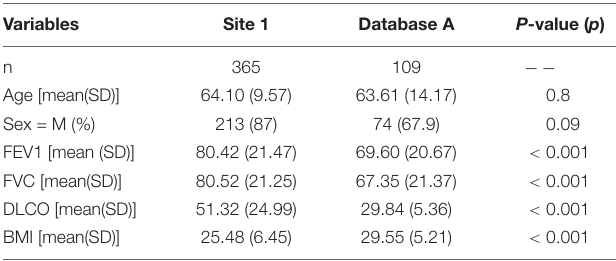
table for different patients along with their mean and standard deviation